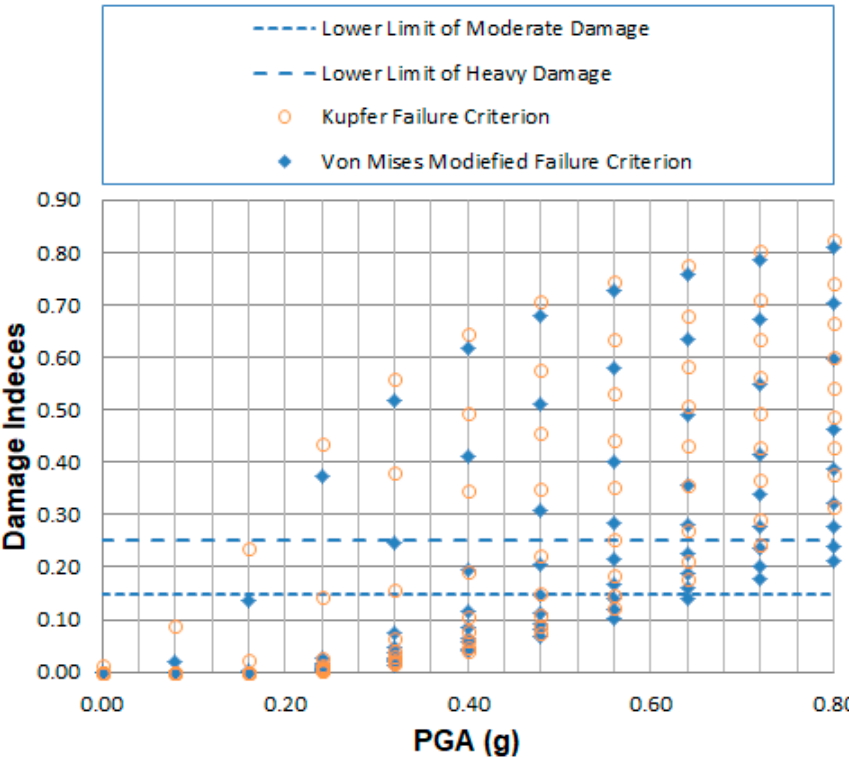
Figure 39. Damage Indices of 2D masonry wall L50H100 (Figure 36a) for opening percentages 0% and two different failure criteria (existing structure).